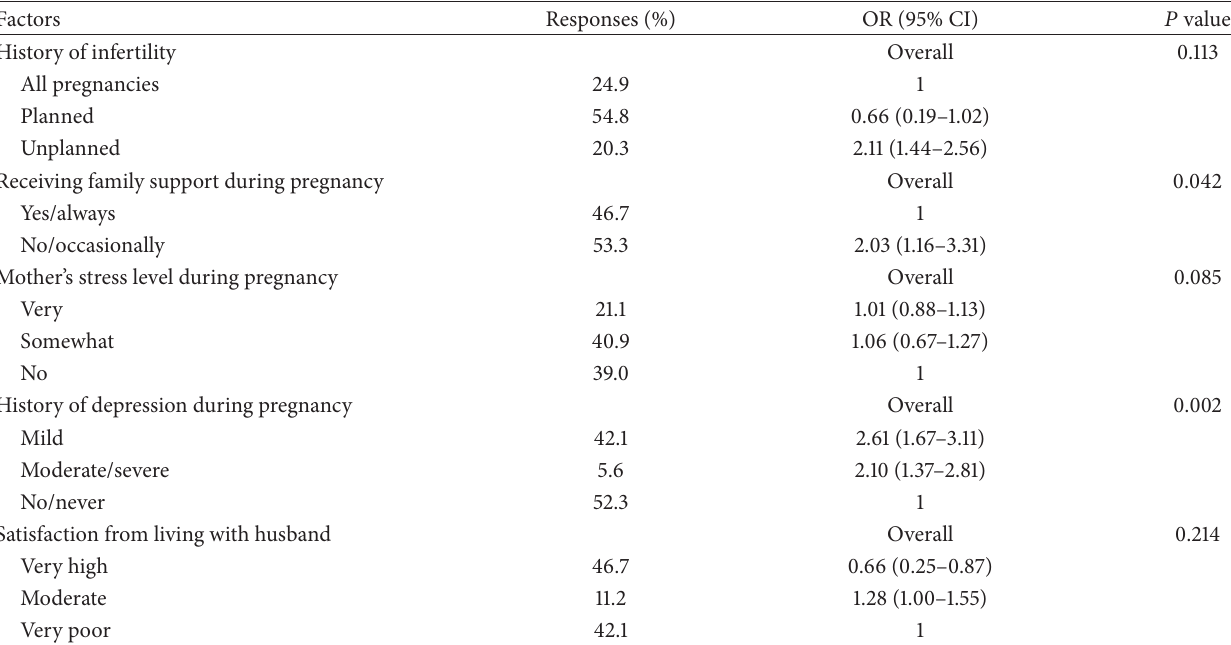
Table 2: Univariate odd ratios (ORs) for psychiatric risk factors of postpartum